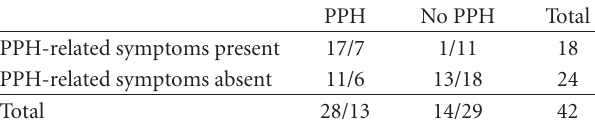
Table 4: Test characteristics of “PPH-related symptoms” for the diagnosis PPH. PPH was defined as a fall in systolic blood pressure of > 20 or > 30mmHg within 2 hours of the start of the meal, measured with a Portapres device, using all 2-minute samples. The sensitivity of PPH-related symptoms for a fall in blood pressure over 20mmHg was 17 / 28 = 0 . 61, the specificity was 13 / 14 = 0 . 93, the positive predictive value was 17 / 18 = 0 . 94 and the negative predictive value was 13/24 = 0.54. For a fall in blood pressure over 30 mmHg the sensitivity was 7 / 13 = 0 . 53, the specificity was 13 / 29 = 0 . 62, the positive predictive value 7 / 18 = 0 . 39 and the negative predictive value 18 / 24 = 0 .